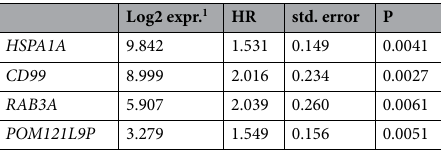
Table 2. Statistical summary of the 4 discovered targets. 1) Log 2 gene expression as median values.